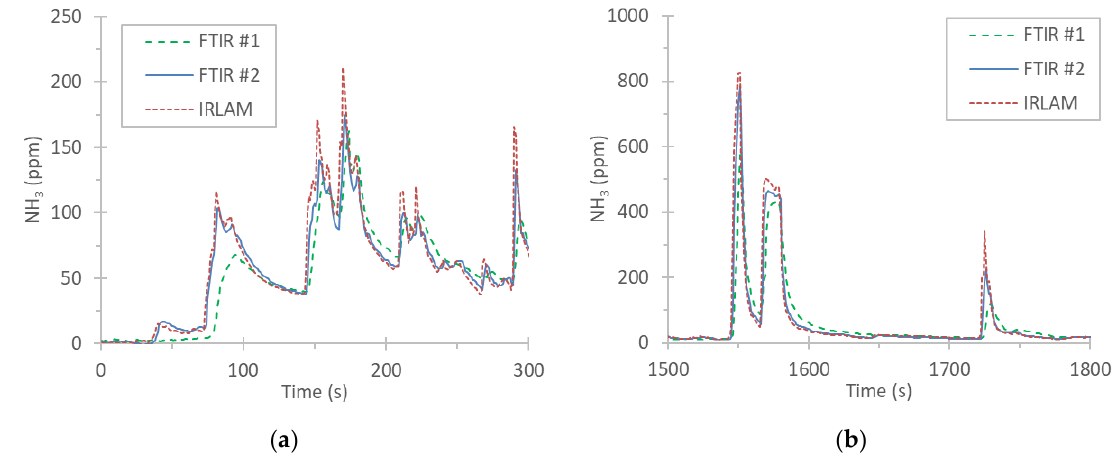
Figure 7. Real time tailpipe NH 3 concentrations during a cold start WLTC of the gasoline Euro 4